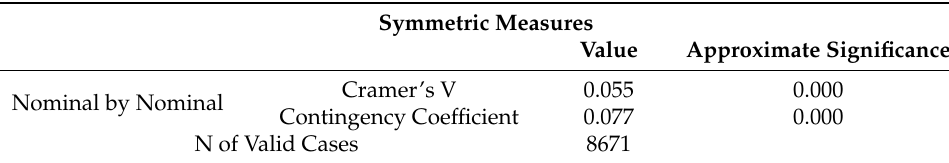
Table 16. Strength of dependence between variables. Source: own research. Symmetric Measures Value Approximate Significance